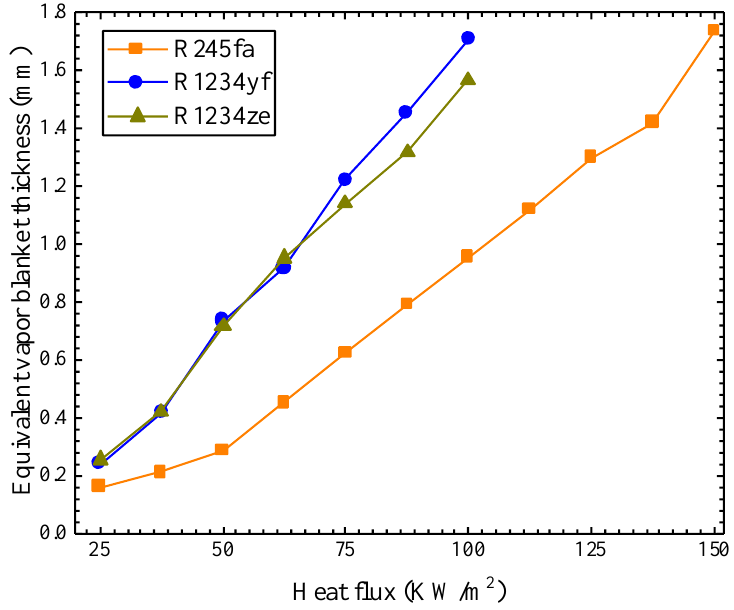
Figure 12. The variation of the equivalent vapor blanket thickness with the heat flux.